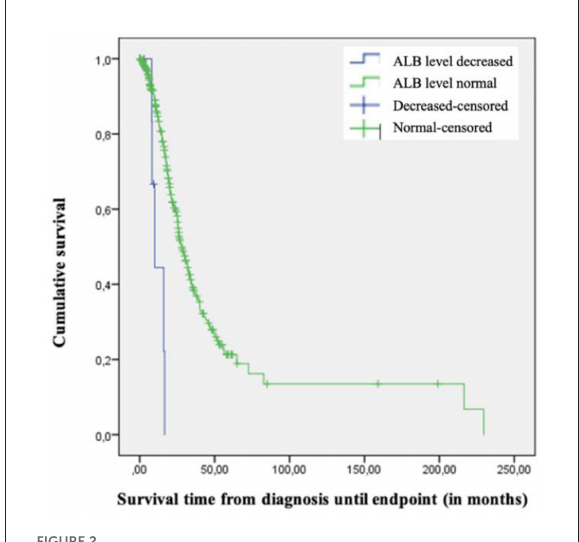
FIGURE2 Kaplan-Meier-Diagram of survival time since diagnosis based on albumin